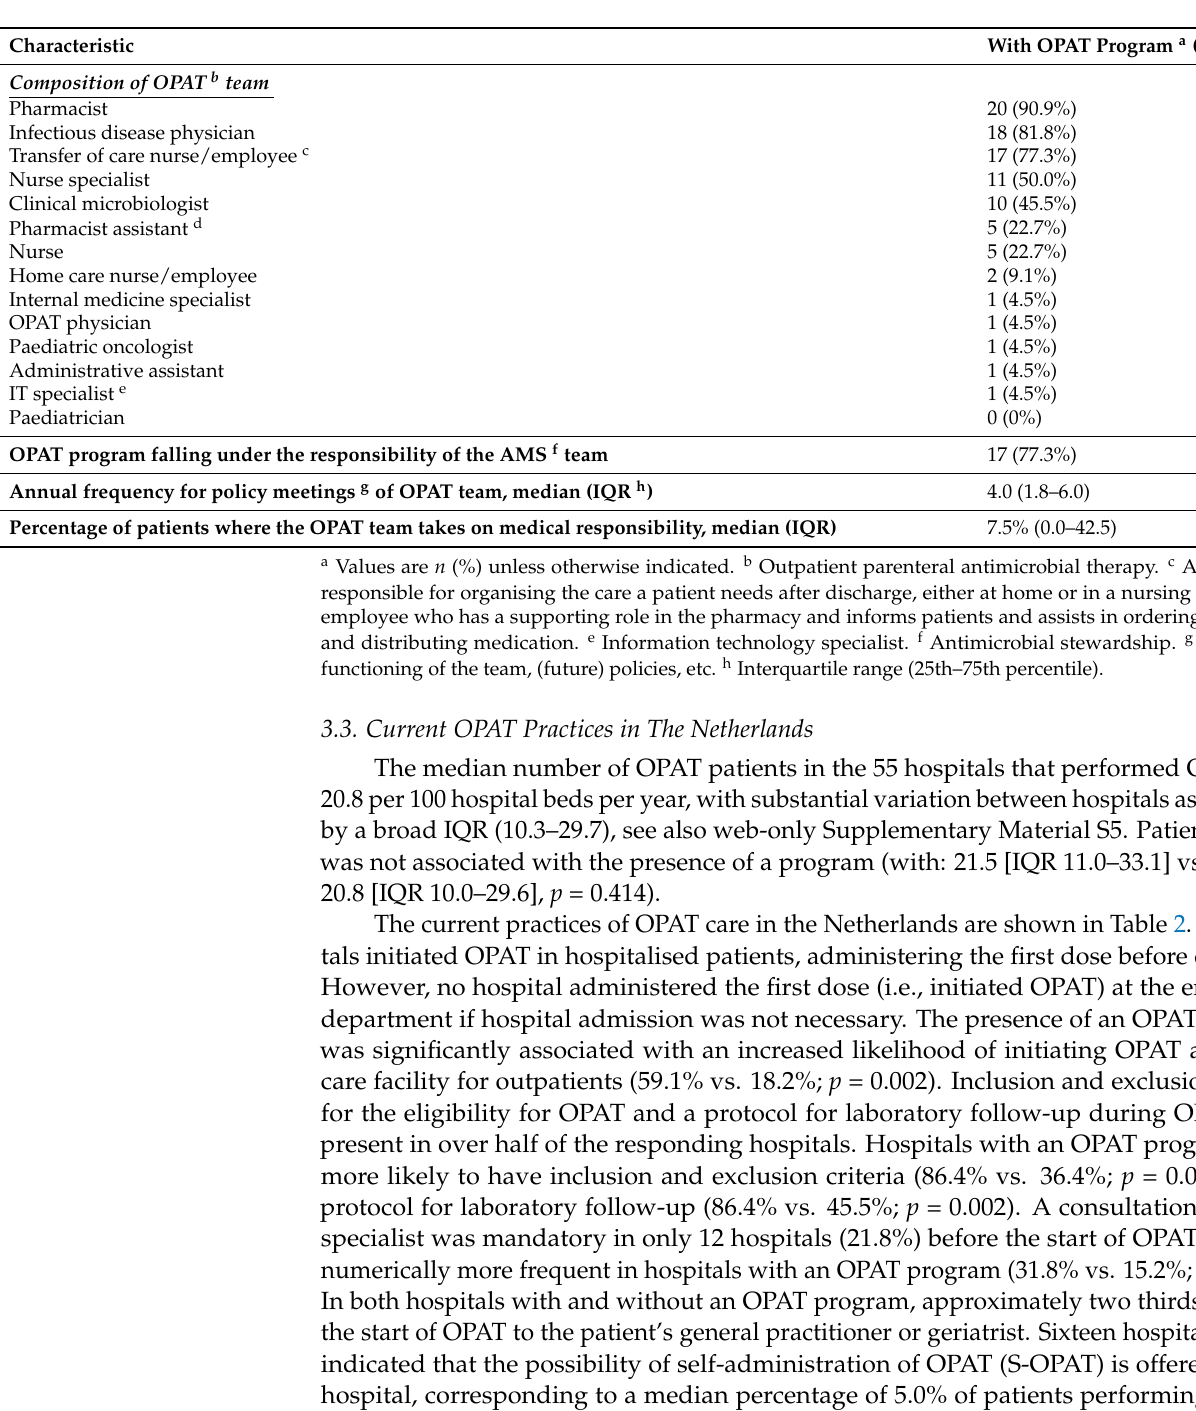
Table 1. Characteristics of the OPAT